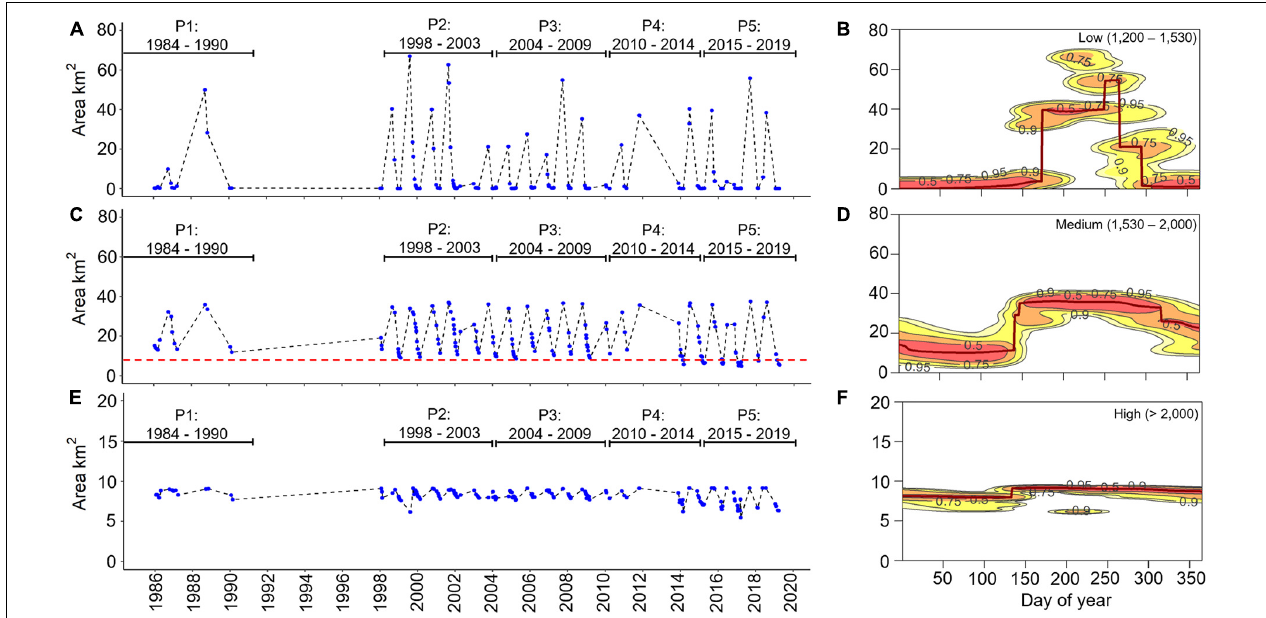
FIGURE 4 | Total snow cover time series 1986–2019 (A,C,E) and seasonality (B,D,F) of the Mocho Choshuenco volcano at three different elevation belts where L, Low (1,200–1,530 m. a.s.l.); M, Medium (1,530–2,000 m. a.s.l.); and H, High ( > 2,000 m. a.s.l.). Note that from 2014 onward the lowest snow cover area is lower than the basal area only for the middle elevational belt (red dotted